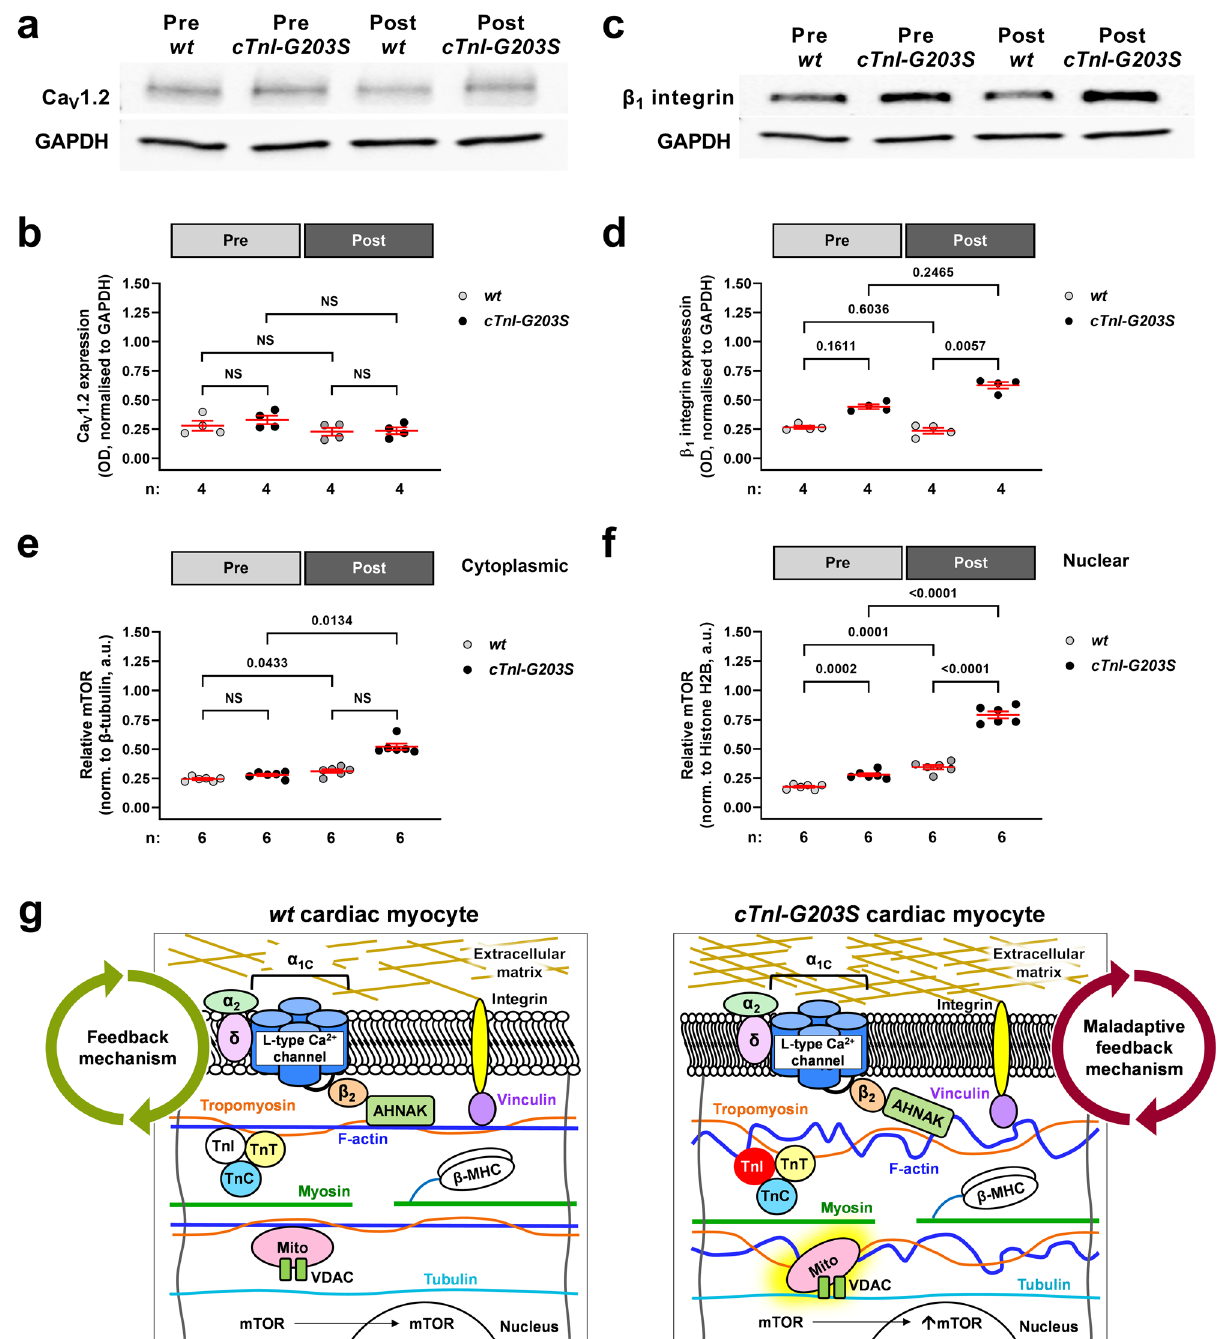
Fig. 7 Alterations in relative cardiac mTOR expression and integrin expression appear to precede cTnI-G203S pathology. Immunoblot analysis of L-type calcium channel ( a , b ) and β 1 integrin ( c , d ) protein expression performed on total heart homogenate pooled from groups of 5 pre- (10 – 15-wk-old) or post-cardiomyopathic (30 – 50-week-old) cTnI-G203S mice and age-matched wt counterparts. Representative immunoblots probed with L-type calcium channel α 1C subunit (Ca V 1.2, a ) or β 1 integrin ( c ) antibody, then GAPDH monoclonal antibody. Densitometry analysis of Ca V 1.2 ( b ) or β 1 integrin ( d ) protein expression, normalized to associated GAPDH expression. n = number of technical repeats. A Browne-Forsythe and Welch ANOVA ( b ) or Kruskal-Wallis test ( d ) determined statistical signi fi cance. Densitometry analysis of relative mTOR expression (calculated as Phospho-mTOR/Total mTOR) performed on cytoplasmic ( e ) and nuclear ( f ) fractions pooled from groups of fi ve pre- or post-cardiomyopathic cTnI-G203S mice and age-matched wt counterparts. β - tubulin and histone H2B antibodies were used as loading controls for cytoplasmic and nuclear fractions respectively. n = number of technical repeats. A Browne-Forsythe and Welch ANOVA ( e ) or Kruskal-Wallis test ( f ) determined statistical signi fi cance. g Schematic indicating structural-functional link between the L-type calcium channel, cytoskeletal network, mitochondria, integrin and the extracellular matrix in wt and cTnI-G203S cardiac myocytes. A disrupted cytoskeletal architecture in cTnI-G203S cardiac myocytes may trigger a maladaptive feedback mechanism between increased cytoskeletal and extracellular matrix stiffness, resulting in a hypermetabolic mitochondrial